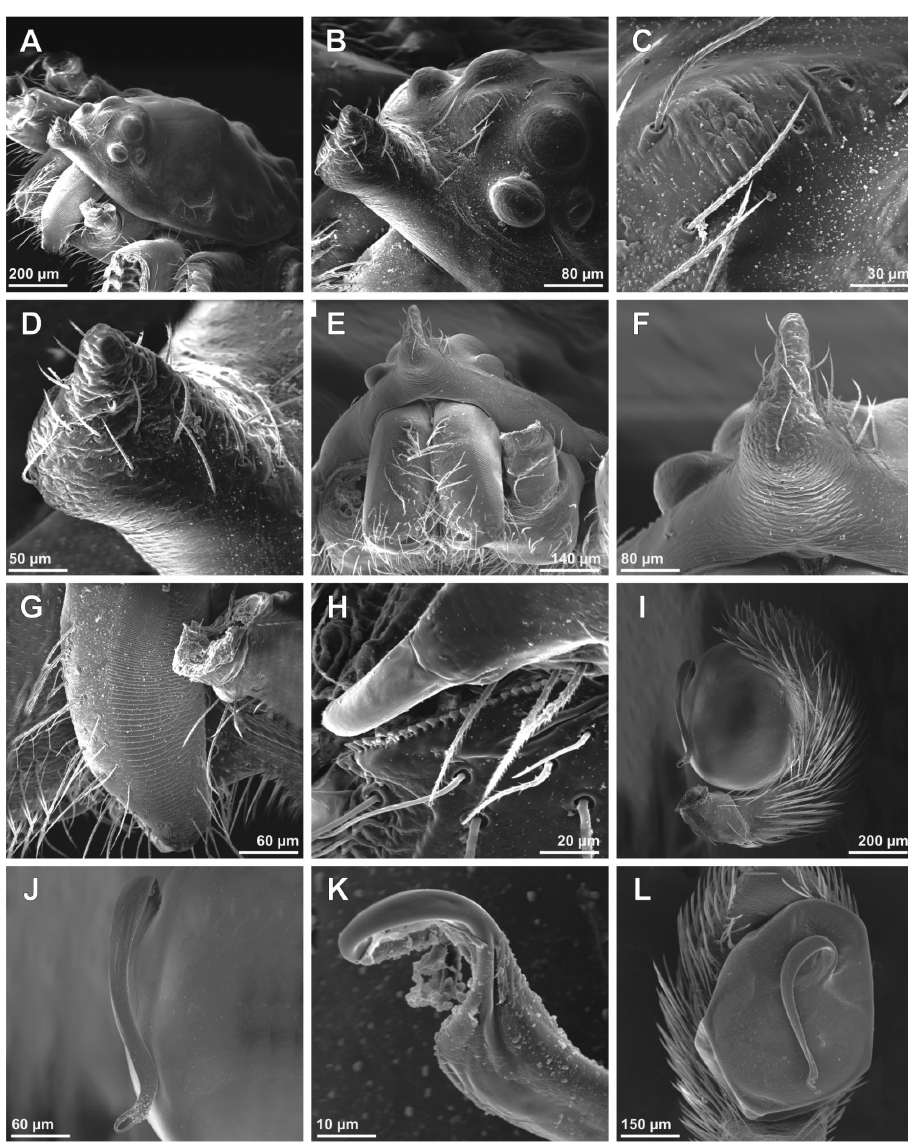
Figure 9. SEM images of Nasutonops xaxado sp. n., male from Serra Talhada, Pernambuco ( A–L ) A carapace, lateral oblique view B ocular area, lateral oblique view C striated area between posterior eyes, detail, dorsal view D clypeal projection, lateral view E same with chelicerae, anterior view F same, anterior view G chelicerae, stridulatory area, lateral view H serrula, lateral view I left pedipalp, retrolateral view J embolus, retrolateral view K tip of embolus, distal area L bulb, ventral